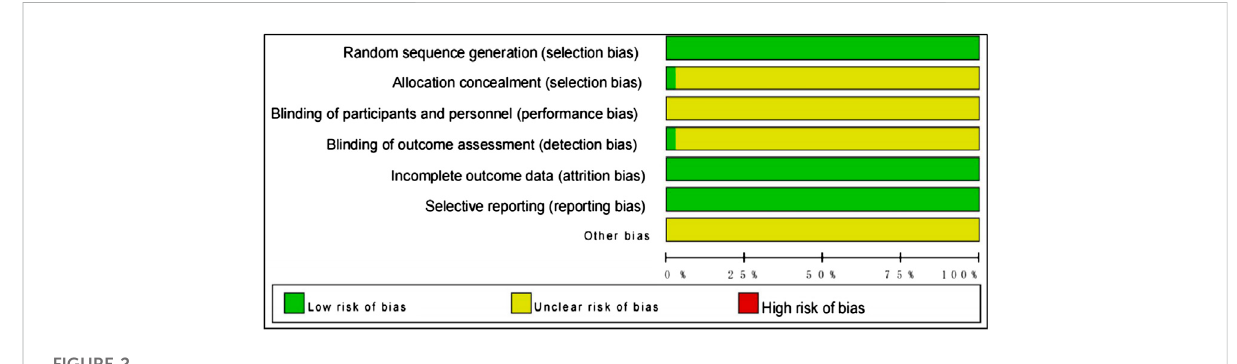
FIGURE 2 Assessment of risk of